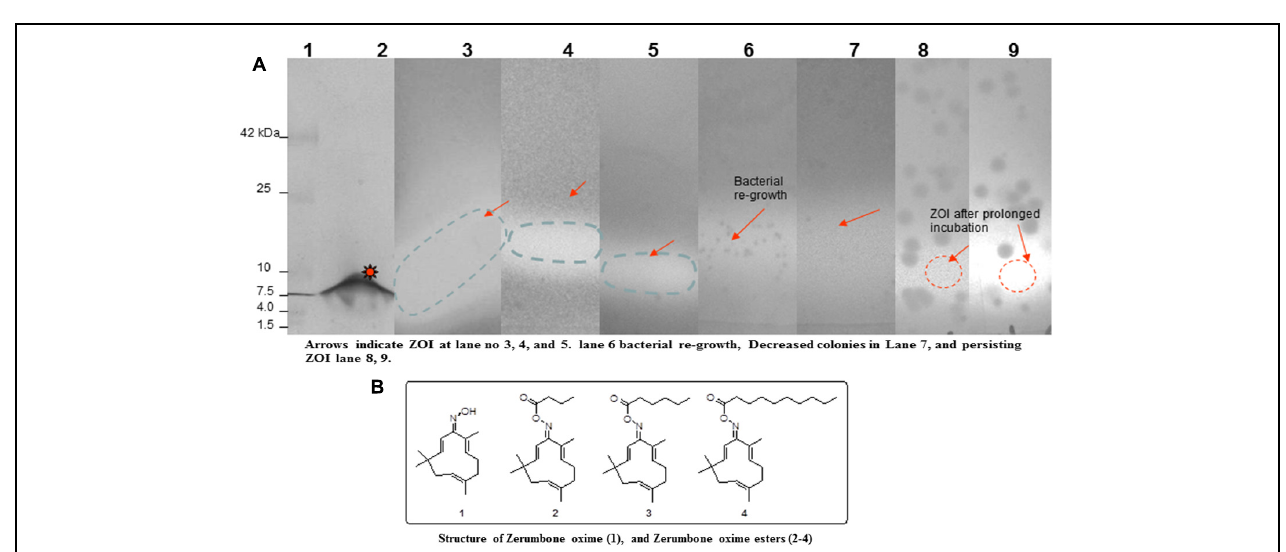
FIGURE 2 | (A) Zymography to show the formation and disappearance of the non-specific zone of inhibition (ZOI). The procedure in brief, After the successful separation of proteins by SDS-PAGE, and native PAGE the gel was rinsed twice with phosphate buffer. Later, it was overlaid on indicator strain containing plate. Left overnight at 37 ◦ C. The sequence shown on the gel are: lane 1, molecular weight marker; lane 2, enterocin; lanes 3–5, overlaid gel showing the ZOI, and decreased ZOI; lane 6, Reappearance of bacterial colonies; and lanes 7–9, existing ZOI after prolonged incubation. (B) Structure of zerumbone oxime and its oxime-esters. Star represents for antimicrobial